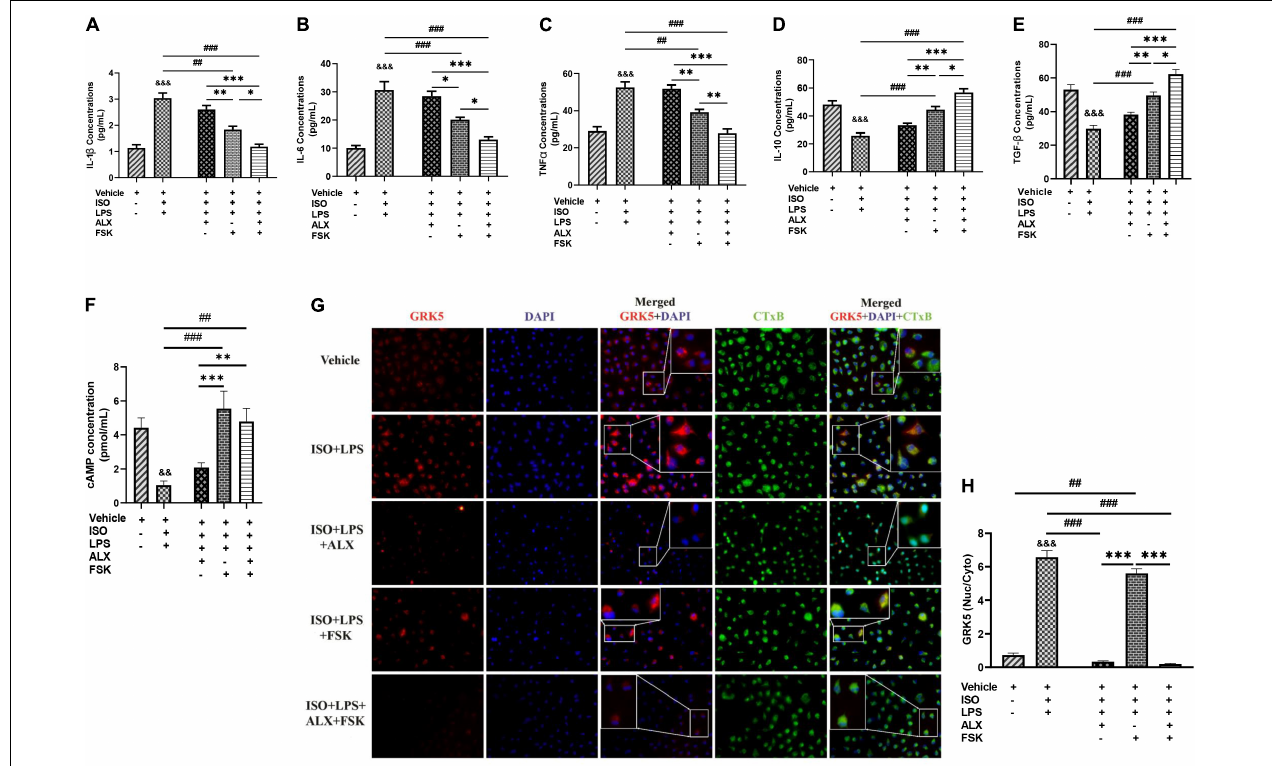
FIGURE 2 | Amlexanox (ALX) and forskolin (FSK) combination inhibits PM φ proinflammatory responses elicited during CCS, mostly via cyclic adenosine monophosphate (cAMP)-mediated immunoregulation. (A-E) ELISA evaluation of inflammatory cytokines (IL-1 β , IL-6, TNF α , IL-10, and TGF- β ) secreted by LPS-challenged PM φ after employing ALX and/or FSK treatment intervention during CCS. (F) cAMP concentrations were assessed to determine the impact of the treatment interventions on ensuring cAMP bioavailability during CCS. The therapeutic groups are ALX treatment, FSK treatment, and ALX and FSK combination treatment. All ELISA evaluations were performed in triplicates ( n = 8 mice per treatment group). ∗ p < 0.05, ∗∗ p < 0.01, ∗∗∗ p < 0.001 among the therapeutic groups; ## p < 0.01, ### p < 0.001 LPS + PM φ + ISO vs. therapeutic groups; && p < 0.01, &&& p < 0.001 vs. LPS + PM φ + Vhl. (G) Representative immunofluorescence of G protein-coupled receptor kinase 5 (GRK5) localizations, nuclei (DAPI), and cytoplasmic membrane (CTxB). (H) The plotted values are the GRK5 (nuclear/cytoplasm) expression ratios assessed from each PM φ ( n = 12–15 cells per four mice per treatment group). Color channels were adjusted in the merged images to enhance the visualization of all the respective fluorescence dyes. ∗∗∗ p < 0.001 among the therapeutic groups; ## p < 0.01, ### p < 0.001, LPS + PM φ + ISO vs. therapeutic groups; &&& p < 0.001 vs. LPS + PM φ + ISO. Data are expressed as mean ± SEM. Data were analyzed using one-way ANOVA, followed by Tukey’s post hoc